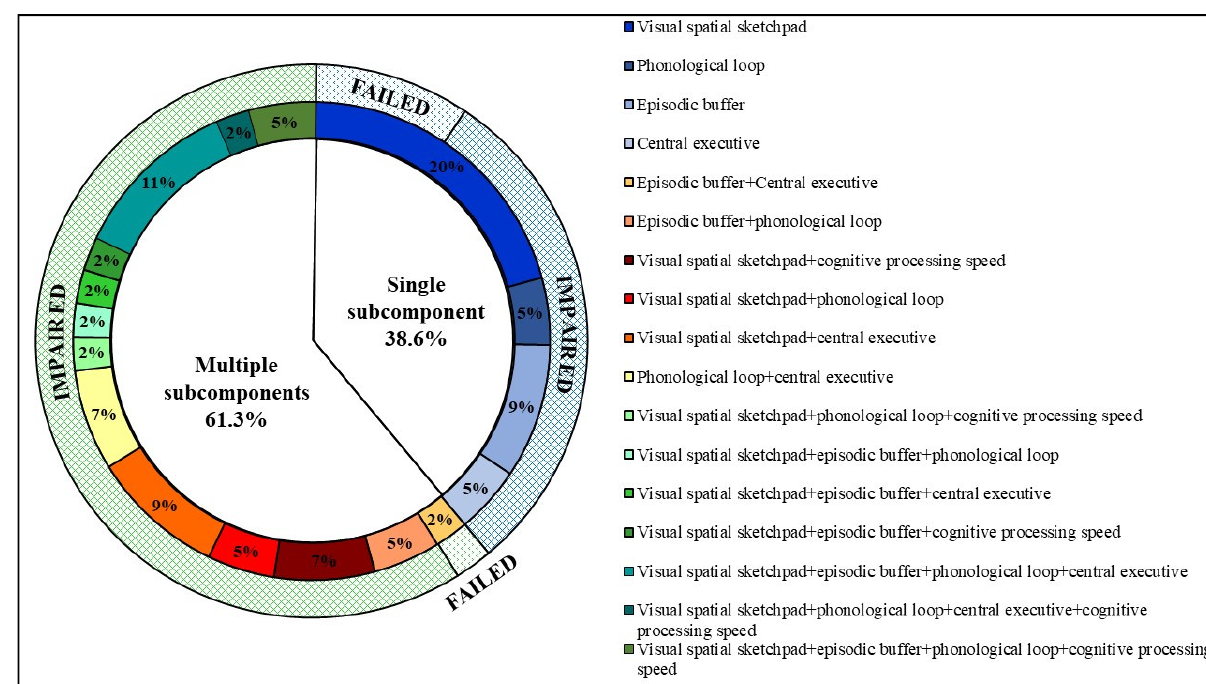
Figure 2. Frequency of WM subcomponent test failure and proportion of patients who were impaired on a single or multiple WM subcomponents. IMPAIRED: refers to a patient with early RRMS who performed below optimal cut-off scores on either a single WM test or multiple WM tests that corresponded to a z-score < −1.5 for the CVLT/SDMT/DS tests or >1.5 for the OM n-back test. FAILED: refers to a patient with early RRMS who performed below cut-off on either a single WM test or multiple WM tests that corresponded to a z-score > −1.5 for the CVLT/SDMT/DS tests or <1.5 for the OM n-back test.